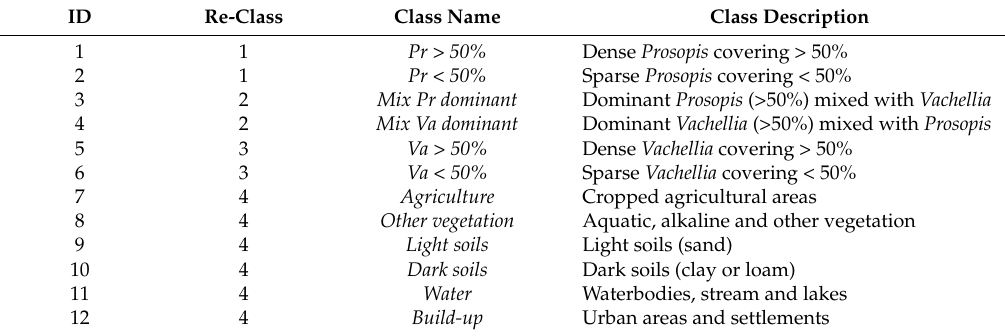
Table 3. Classification scheme with identifier (ID), re-classified ID, class name and